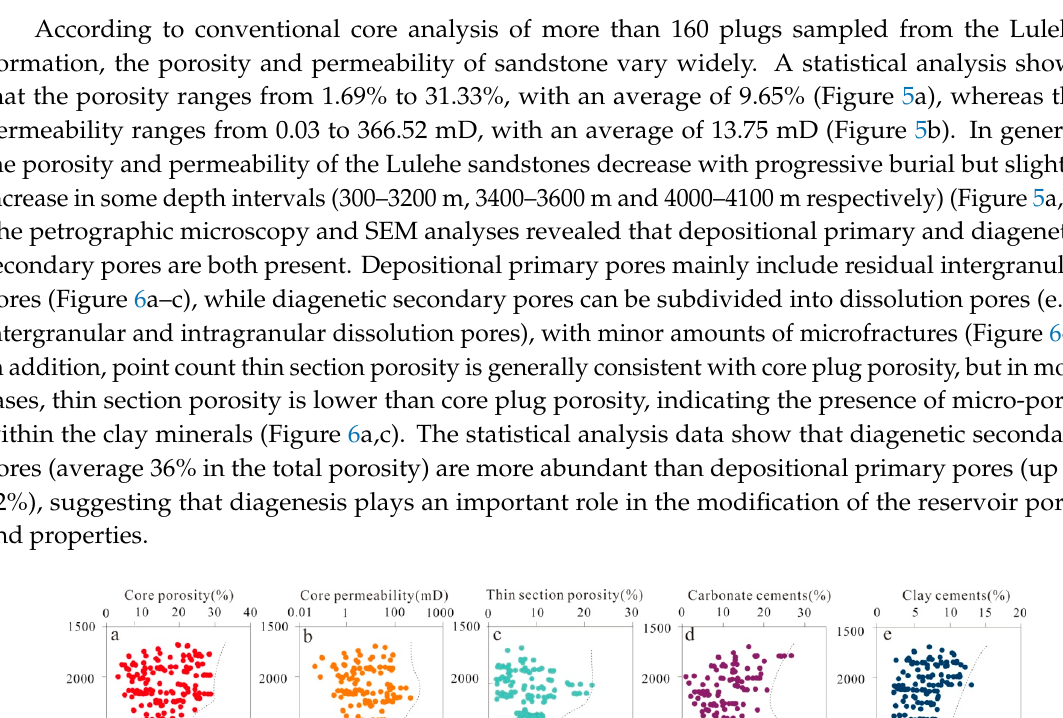
Figure 4. Rock composition lithology and sorting distribution of the Lulehe Formation sandstone reservoirs: ( a ) Lithology distribution; ( b ) Ternary diagram illustrating the classification of sandstone on base of Folk’s [36] classification; ( c ) Sorting distribution.